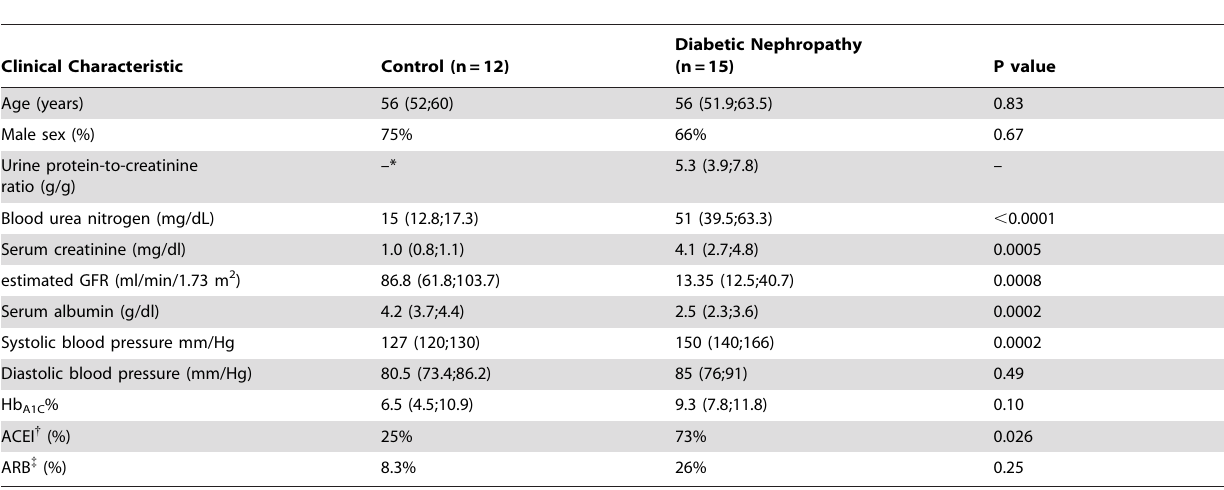
Table 1. Clinical characteristics of control and Type 2 diabetic nephropathy patients.